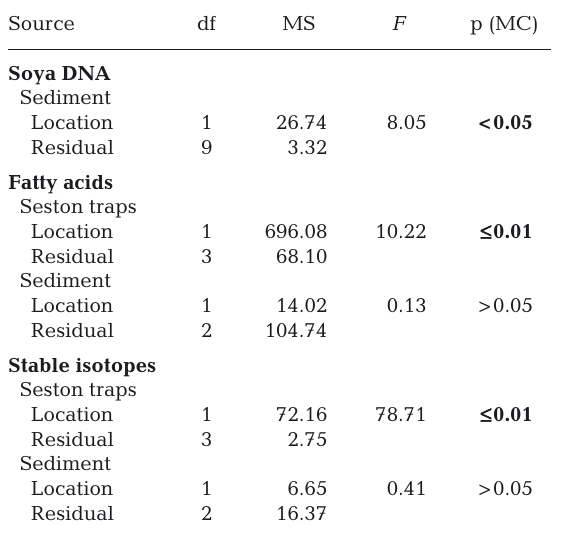
Table 3. PERMANOVA of environmental differences be- tween locations for 3 different biochemical techniques: soya DNA, fatty acid profiles and stable isotopes. MC: Monte Carlo test; significant values (p < 0.05) are given in bold